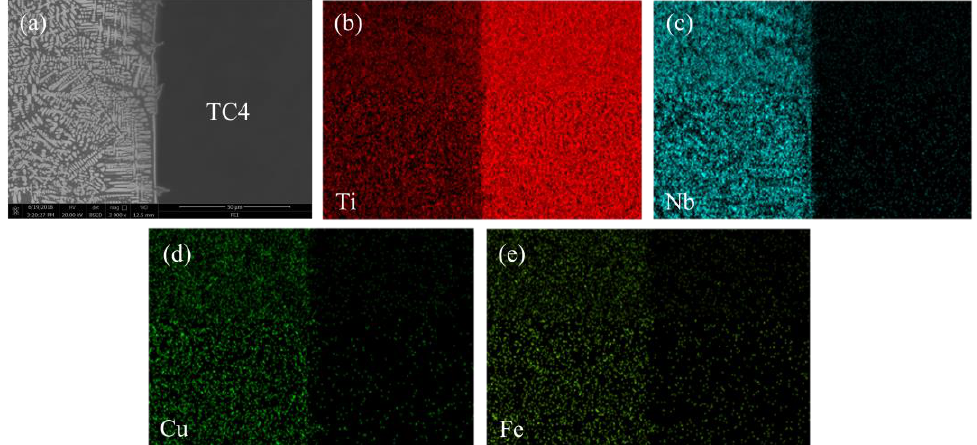
Figure 5. Distribution of the main elements in the weld metal of titanium alloy side of the welded joints at a welding speed of 10 mm/s (EBW-3), including ( a ) the BSE image, ( b ) the Ti map, ( c ) the Nb map, ( d ) the Cu map and ( e ) the Fe map.